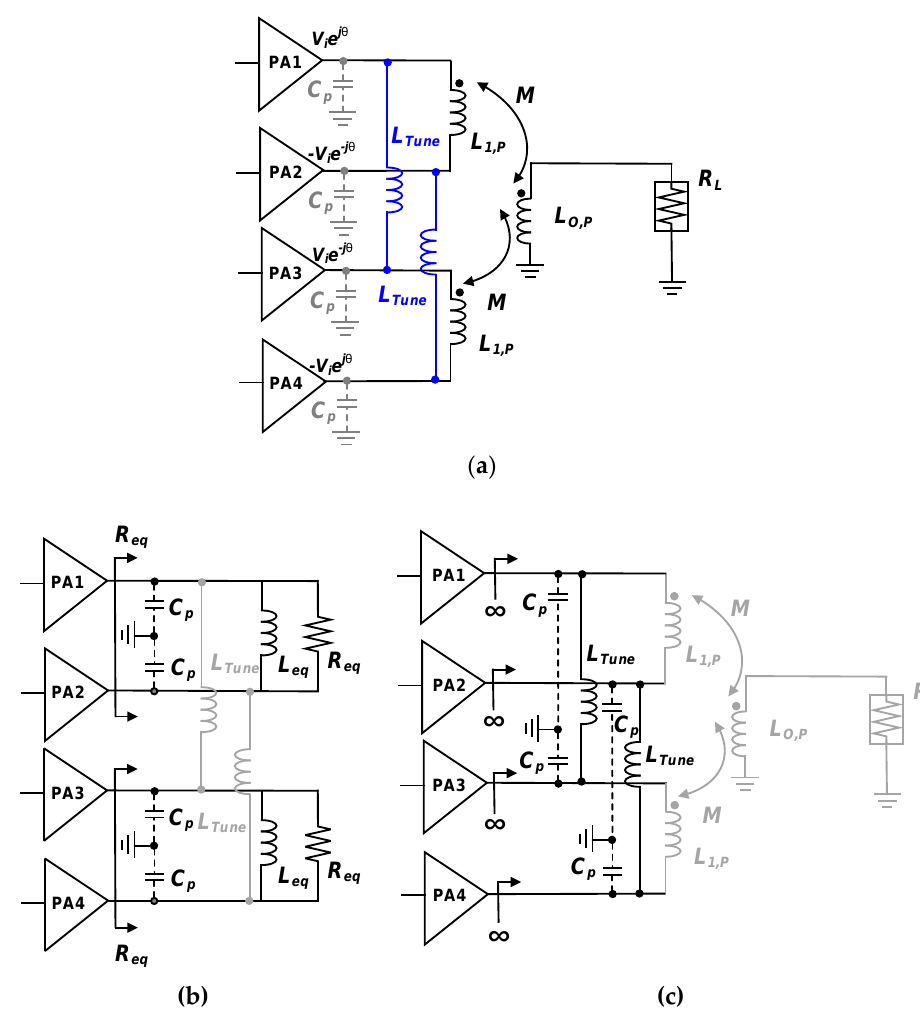
Figure 8. ( a ) Proposed structure for class-D PA with PCT; ( b ) in-phase mode; ( c ) out-of-phase mode.